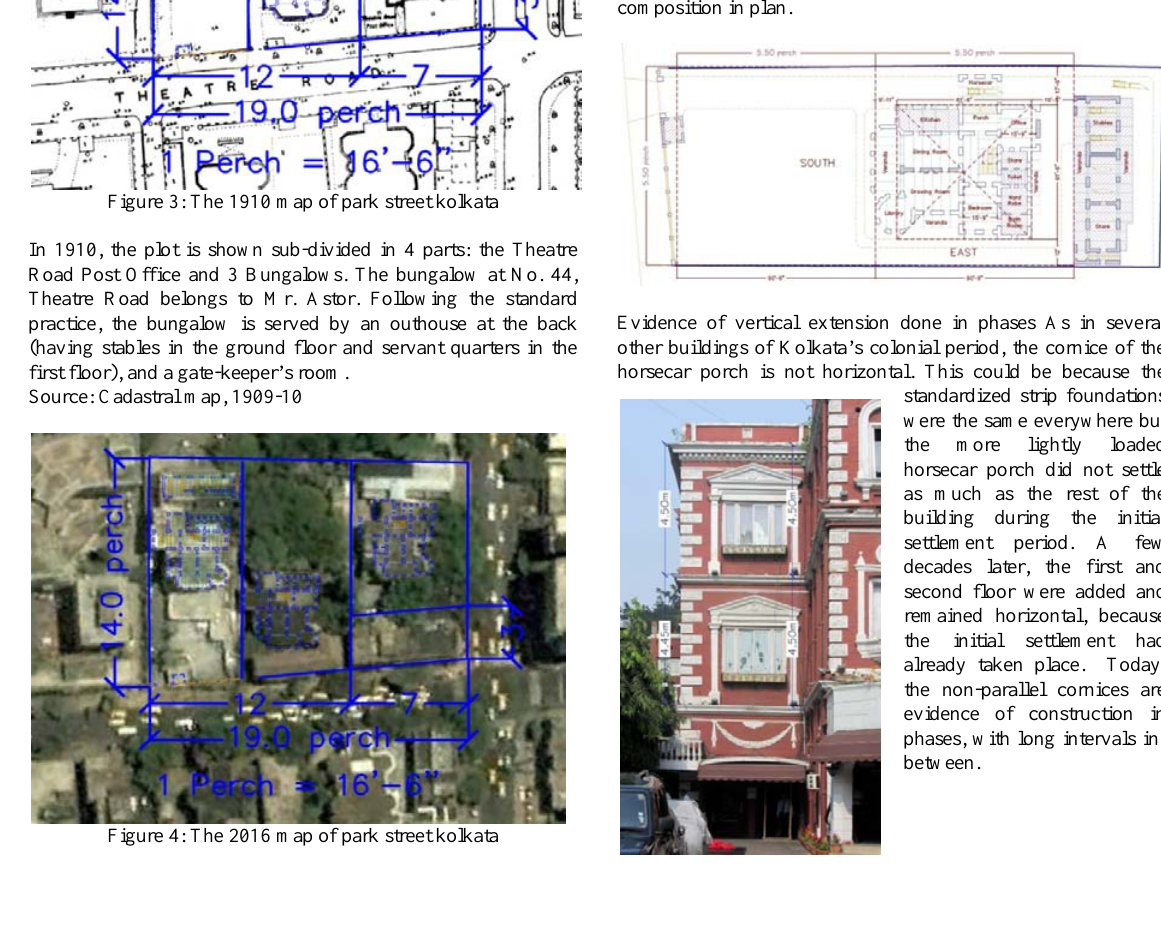
1. Plot : Divided in two equal squares and a leftover at the back, for the front garden, the house, and the service building respectively. 2. House : Inscribed in a square divided in 4 parts. The services are grouped in two narrow bays on the North and West, leaving the East and South fully open to the living rooms. The stairwell octagonal tower on the East and South facades, complete the composition in